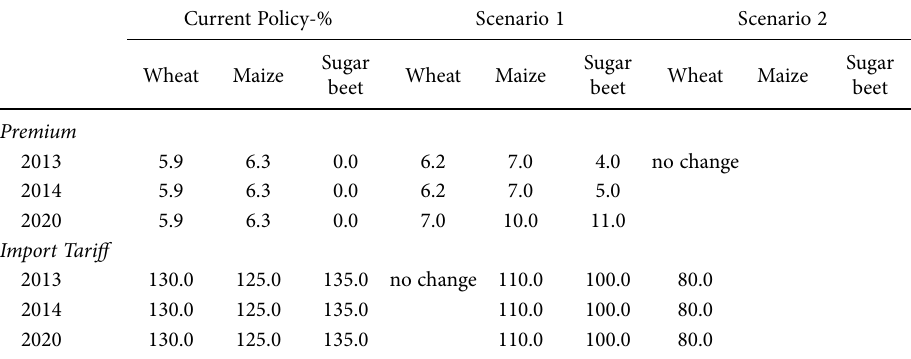
Table 2. Policy assumptions.